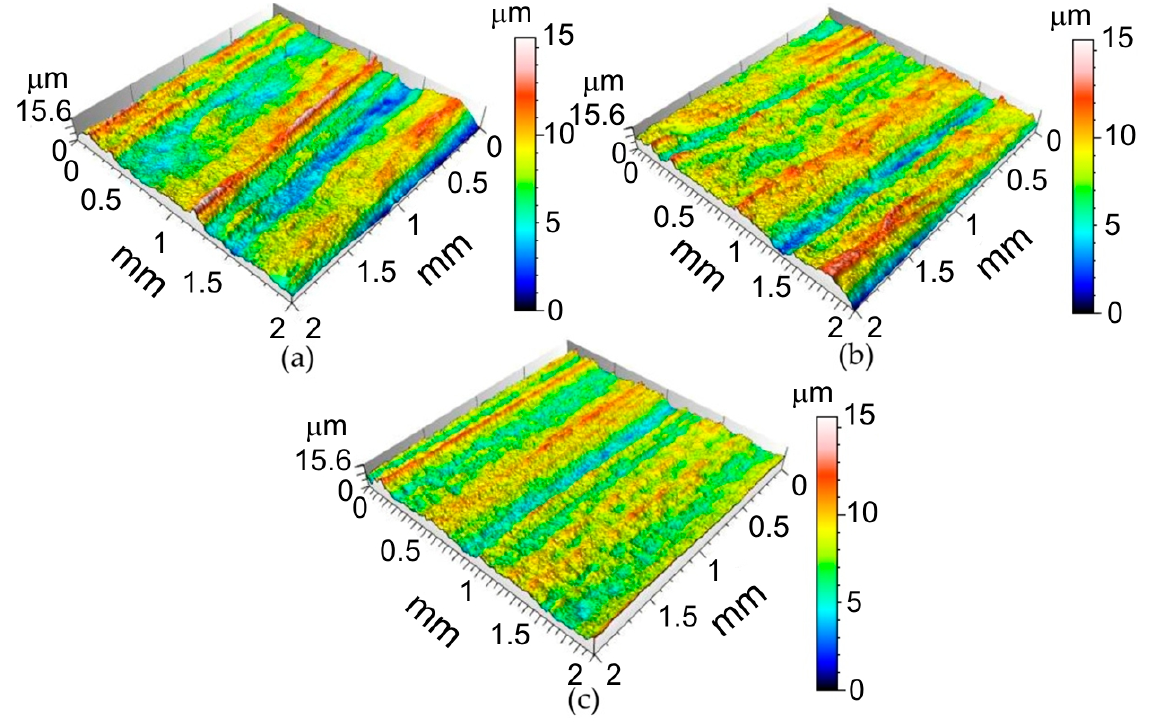
Figure 6. Surface topographies of the inner surface of ribs formed in 0.4-mm-thick EN AW-2024-T3 Alclad fabricated at with the following conditions: ( a ) a p = 0.4 mm, v = 18 rpm; ( b ) a p = 0.4 mm, v = 202 rpm; ( c ) a p = 0.2 mm, v = 202 rpm. Table 5. Basic amplitude parameters of the surface roughness of the ribs formed in 1-mm-thick EN AW-2024-T3 sheets.